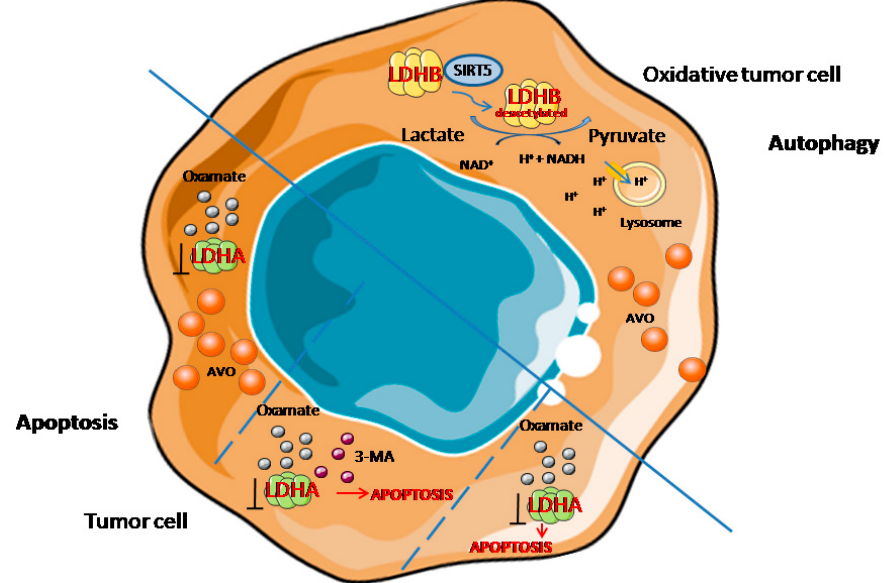
Figure 4. The role of LDHA and LDHB in autophagy / apoptosis of tumor cells. 3-MA = 3-Methyladenine, AVO = acidic vacuolar organelles, LDHA = lactate dehydrogenase A, LDHB = lactate dehydrogenase B, SIRT5 = Sirtuin 5. Graphical elements adapted from Servier Medical Art. The role of LDHA and LDHB in tumor biology is more complex than was initially expected.